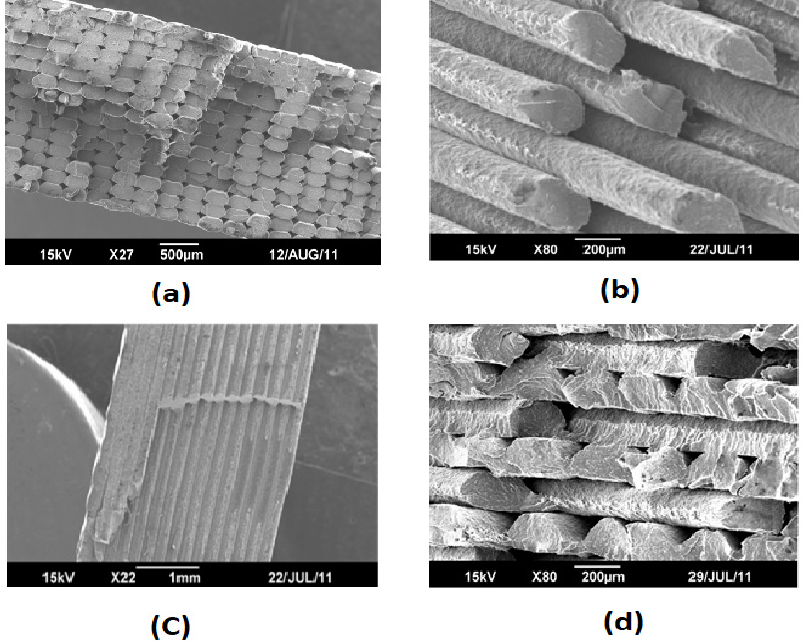
Figure 14. SEM image from fractured surface ( a ) 0°, ( b ) 45°, ( c ) 90° and ( d ) +45°/ − 45°. Reprinted with permission from Ref. [48]. 2011, IntechOpen.